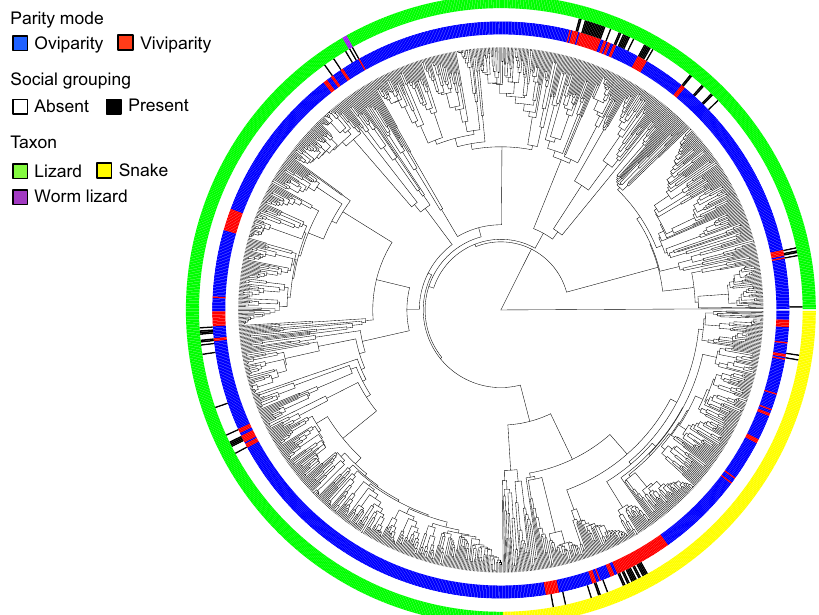
Fig. 2 Phylogenetic distribution of social grouping across squamate reptiles. Phylogeny pruned from ref. 11 to contain only those species included in analyses ( n = 1210, see Methods for details on species